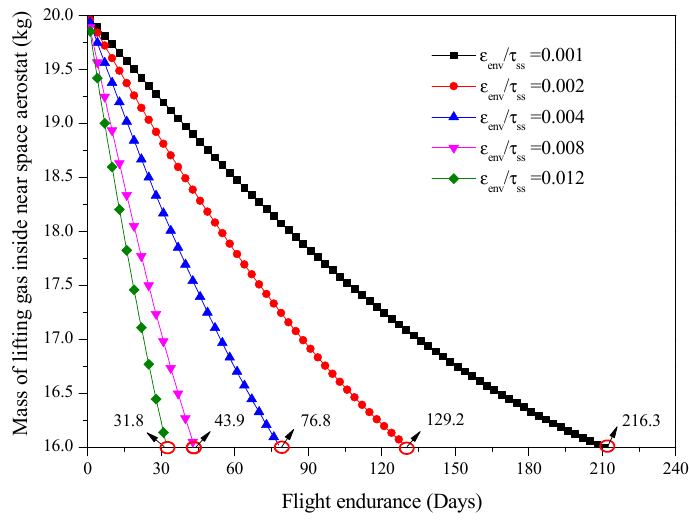
Figure 8. Effects of ε env / τ ss on the mass of lifting gas inside a near-space